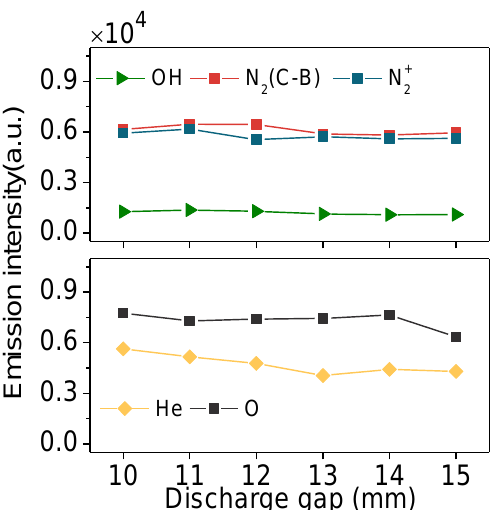
Figure 9. Effects of the discharge gap on the emission intensities of N 2 (C 3 Π u → B 3 Π g ), N + (B 2 Σ → X 2 Π ), OH (A 2 Σ → X 2 Π ), O (3p 5 P → 3s 5 S 0 ), and He (3s 3 S → 2p 3 P 0 ).